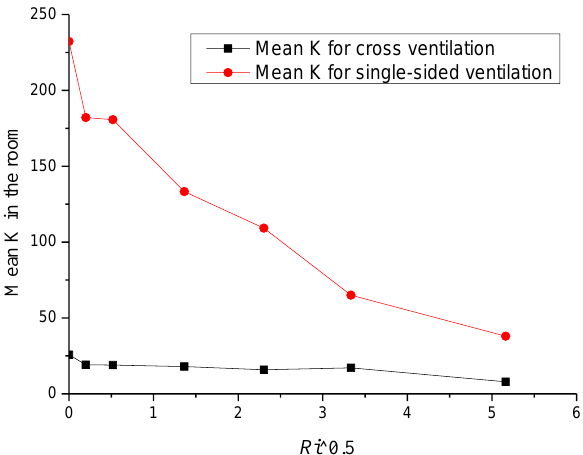
Figure 16. Mean K in the room, plotted against the square Ri numbers for cross- and single-sided ventilation.